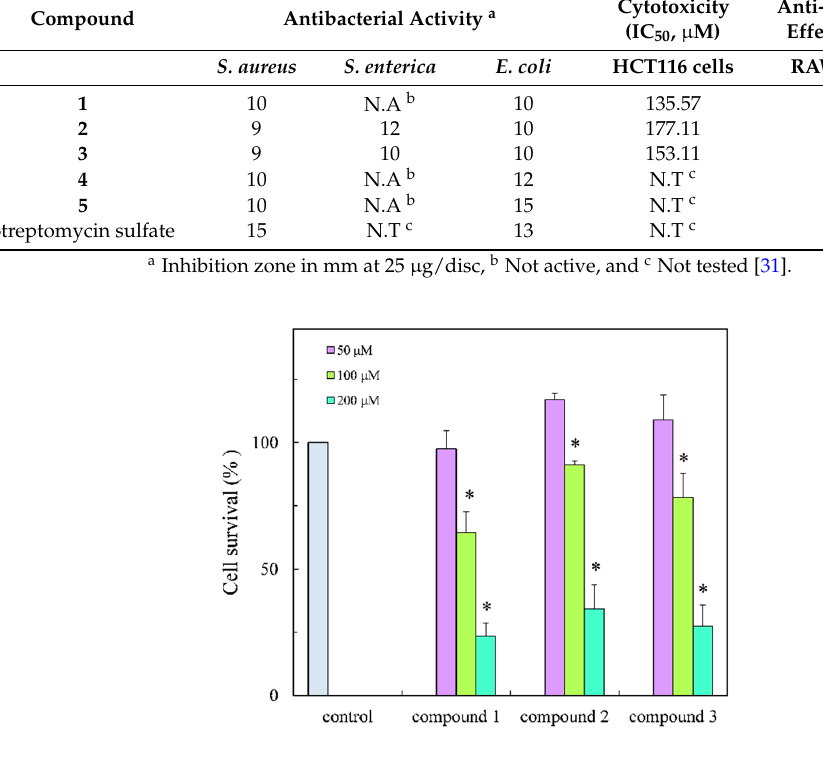
Figure 4. Cytotoxicity of 1 – 3 against HCI116 colon cancer cells. Significance * p < 0.01 was considered statistically significant for control.